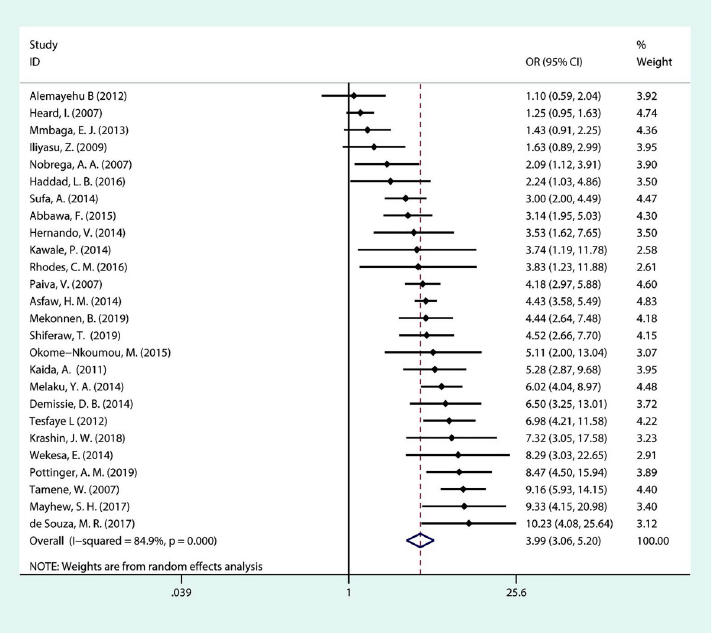
Fig 8. Forest plot of pooled OR for fertility desire in PLHIV (having no children vs having one or more children).